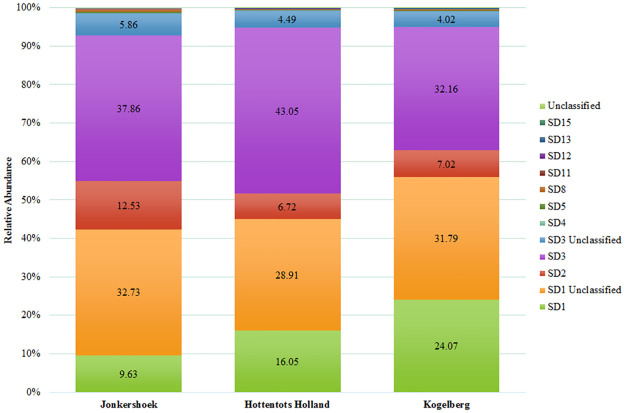
The acidobacterial subdivision community composition based on 16S rRNA gene sequence analysis for Jonkershoek, Hottentots Holland, and Kogelberg.